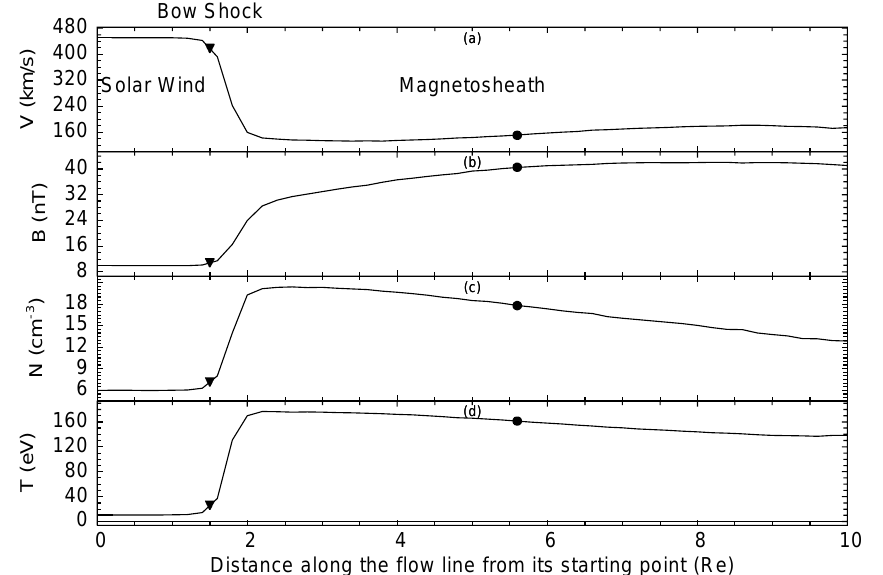
Fig. 14. Some parameters along the green flow line in Fig. 13. The solar wind is on the left-hand side and the magnetosheath is on the right-hand side. The horizontal axis is the distance along the flow line from its starting point at (15, 0, -2.5) R E . The big jump at ∼ 2 R E is the bow shock. The black dot on each line corresponds to the black dot in Fig. 13 which marks the location where the flow line crosses the slow mode front.